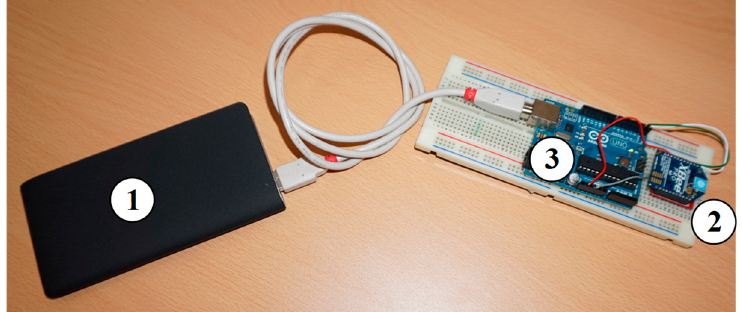
Figure 6. Components used in the static system.